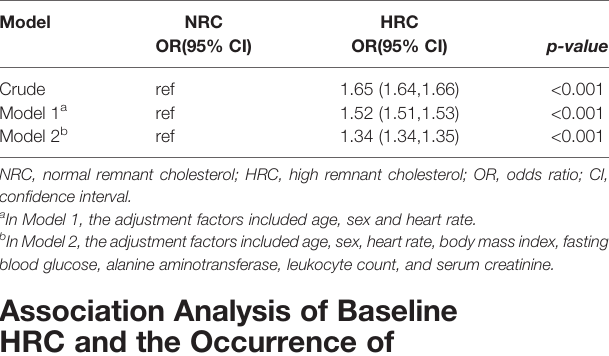
TABLE 3 | HRC was associated with hypertension in cross-sectional